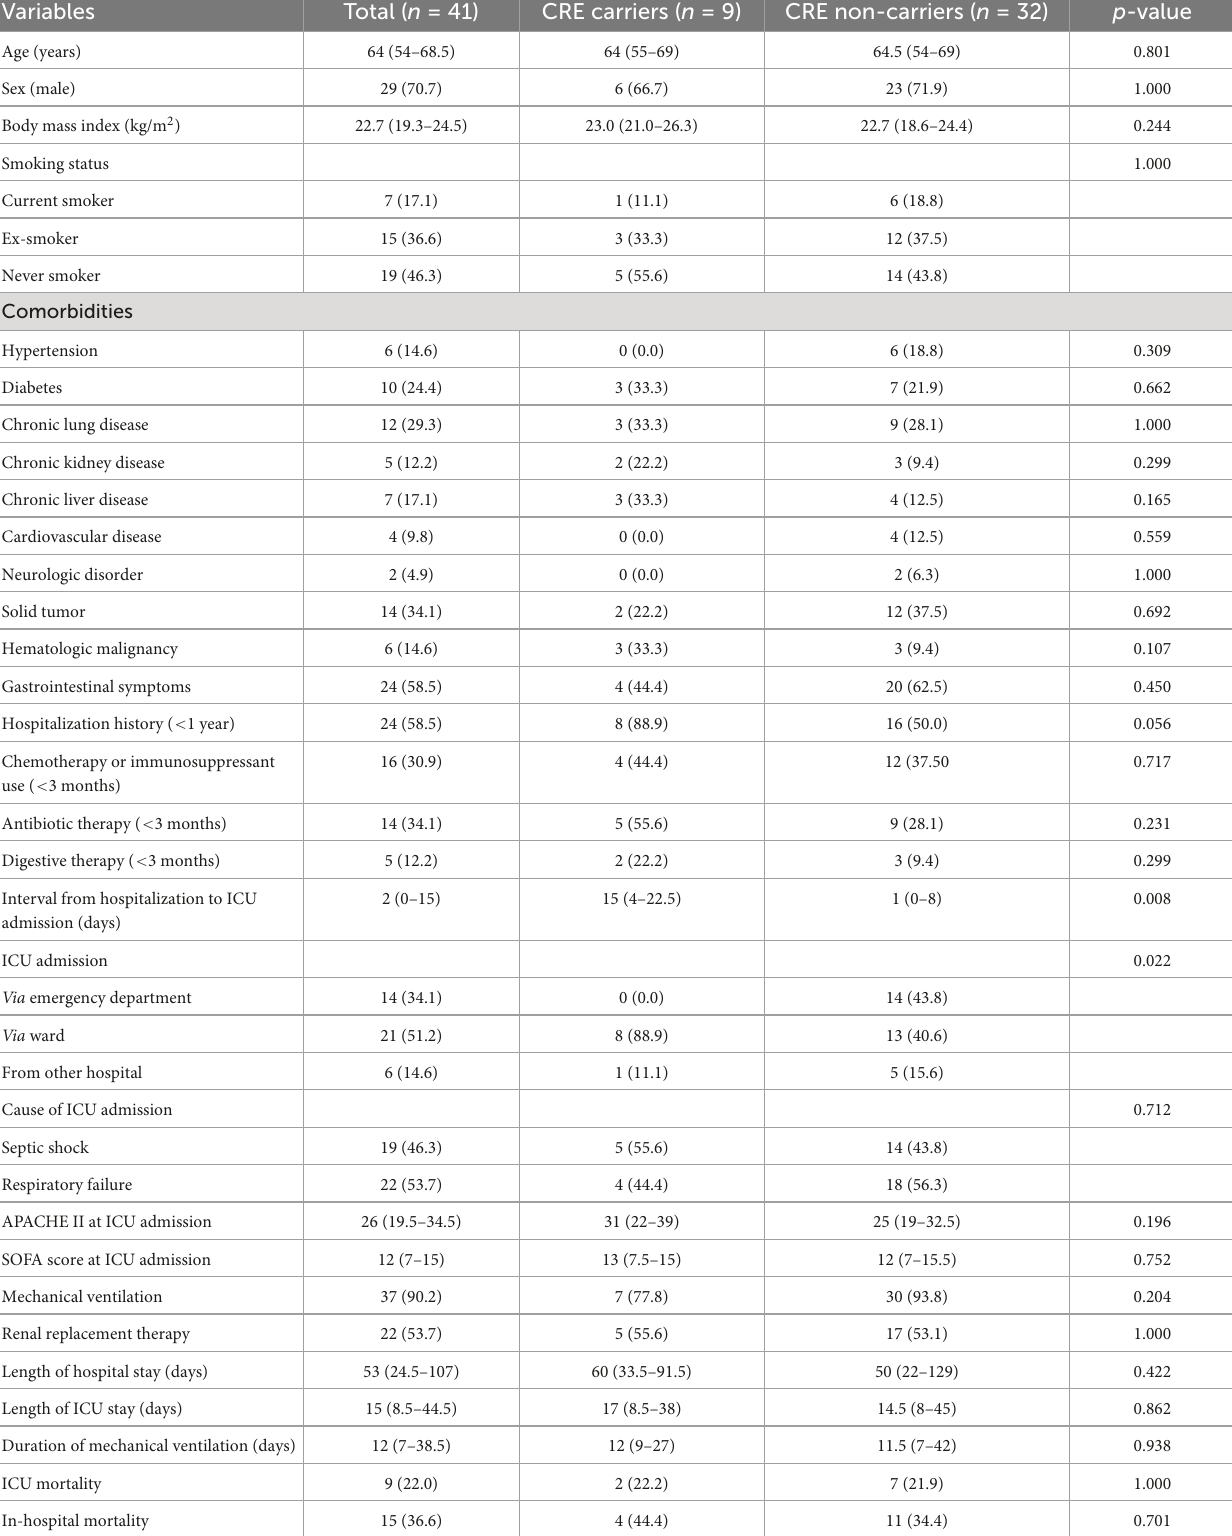
TABLE 1 Baseline characteristics of the